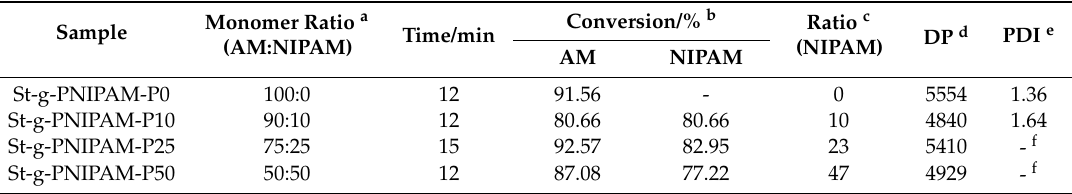
Table 1. Experimental data for St-g-(PAM-co-PNIPAM) synthesized by Cu 0 -mediated living radical polymerization (LRP). Sample